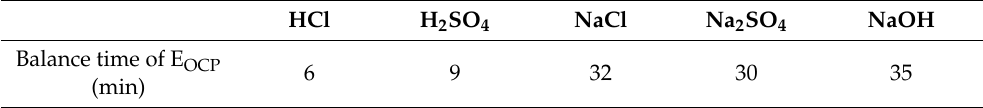
Table 8. Balance time of E OCP for M2 after finishing the measurement of the cathodic